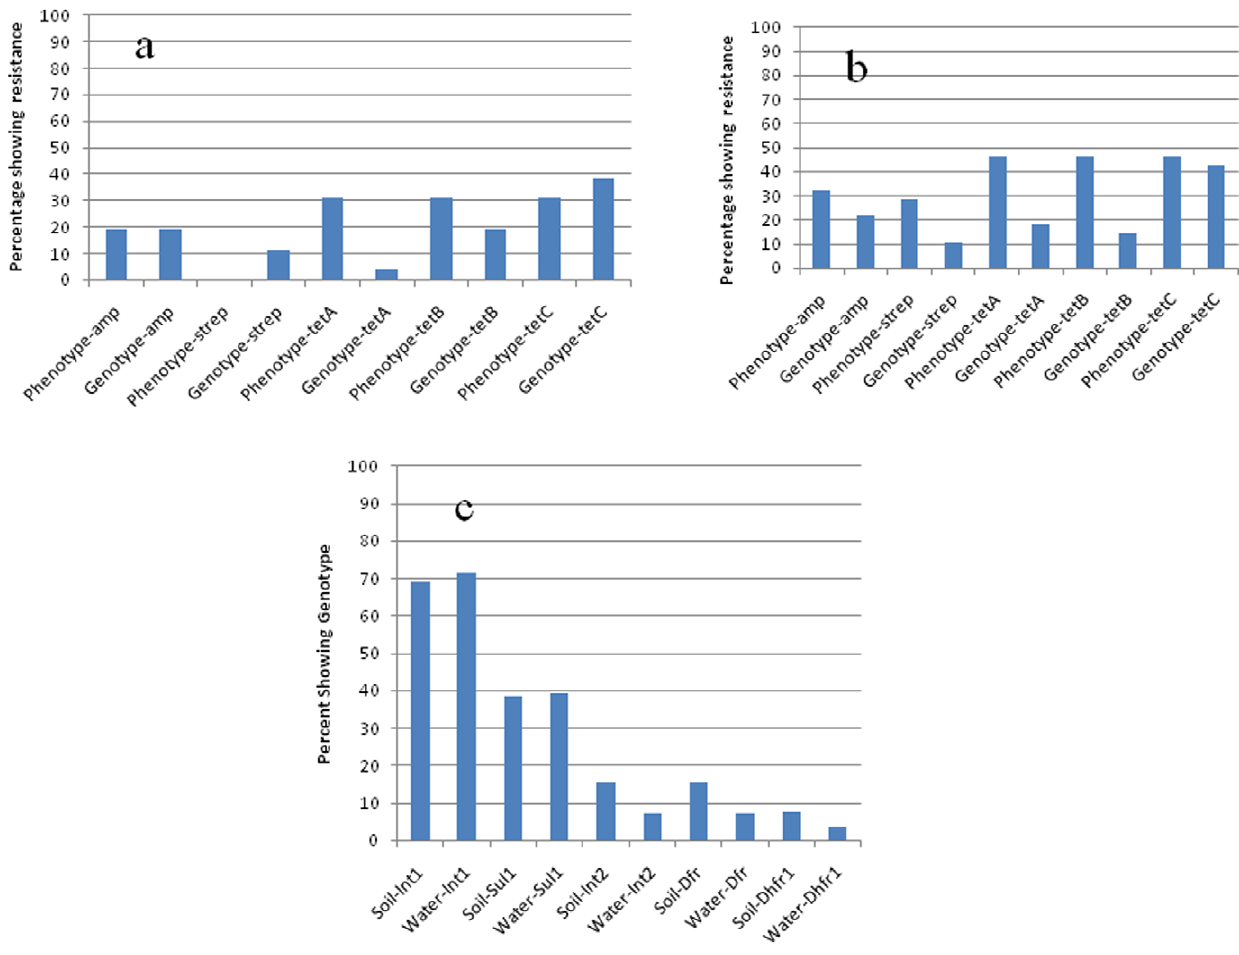
Figure 4. Correlation of antimicrobial susceptibility and presence of resistance gene sequences of E.coli isolates from (a) sediment and (b) surface water. Integrons in sediment and surface water (c).